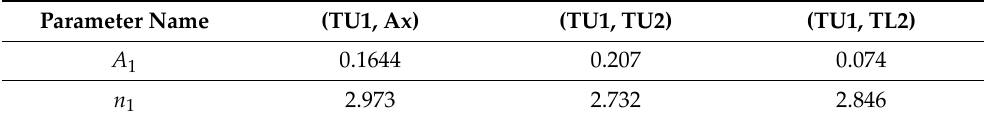
Table 3. Parameters of equation (21) for various ways of supplying liquids to MRISF‑2 ( Q is in L/min, ε is in